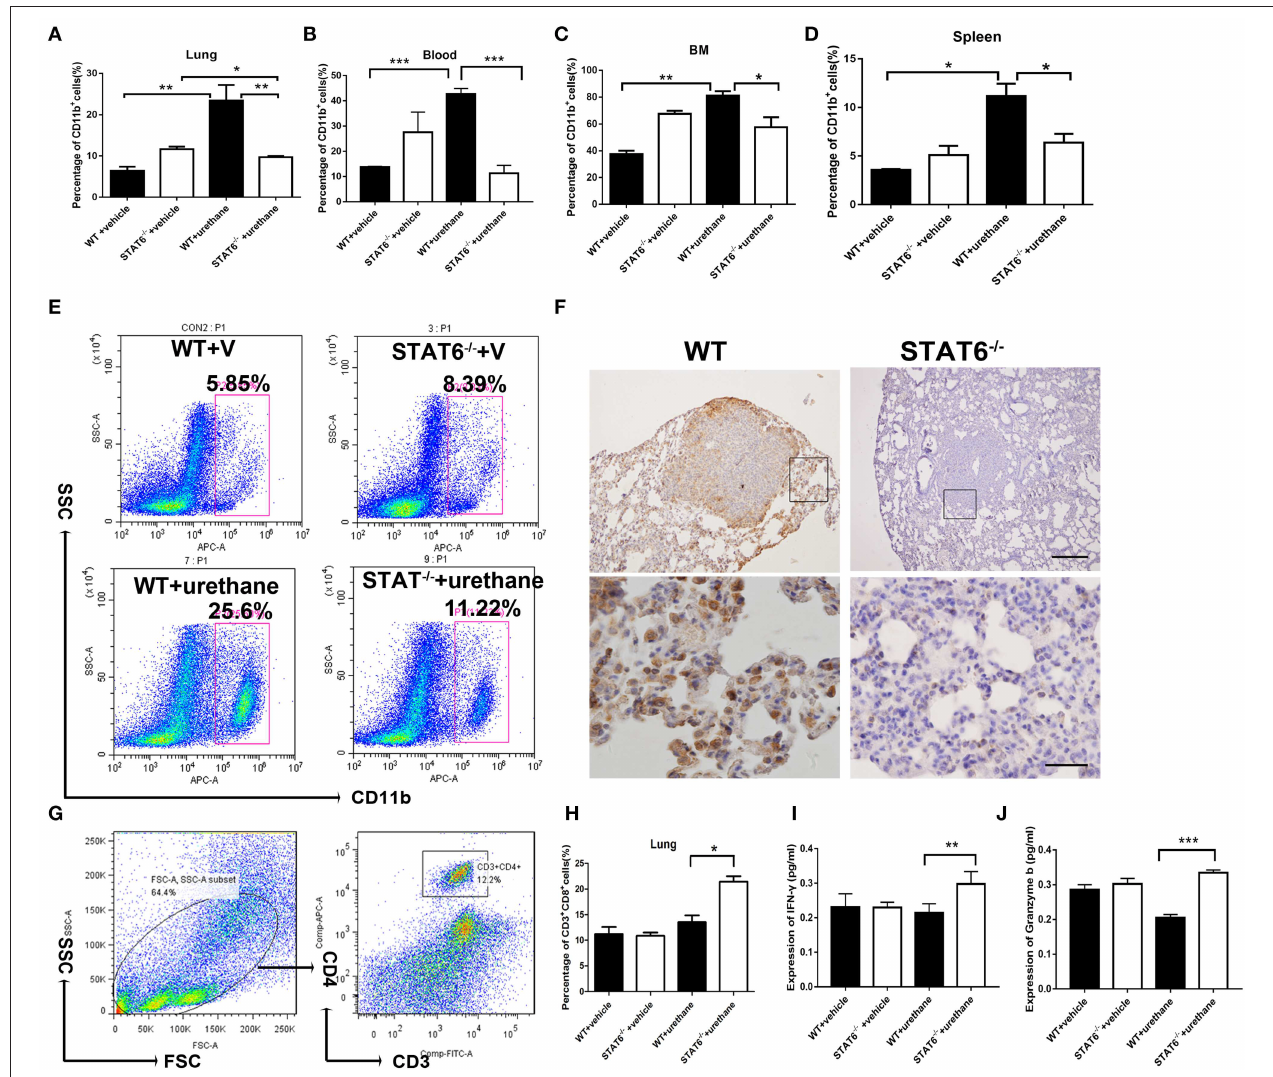
FIGURE 4 | CD11b + cell staining and analysis in tumor-bearing mice. (A–D) Quantification of the percentages of CD11b + cells in the blood, lung, bone marrow, and spleen in WT + vehicle, signal transducer and activator of transcription 6 (STAT6) − / − + vehicle, WT + urethane, and STAT6 − / − + urethane groups. (E) Representative flow cytometry analysis results of CD11b + cells in the lung of STAT6 − / − and WT mice 6 months after vehicle or urethane inoculation. (F) Immunohistochemical (IHC) staining of CD11b + in the lung. The upper and lower bars represent 500 and 200 µ m, respectively. Images in the same row are of the same magnification. (G) Flow cytometry analysis diagram of CD3-CD4 in mice. (H) Percentage of CD3 + CD8 + cells by flow cytometry analysis. (I,J) Expression of cytokines associated with cytotoxic T lymphocytes such as interferon (IFN)- γ and granzyme-b (pg/ml). Data are presented as mean ± SD of one representative experiment. Total number of gated cells was 5 × 10E4. Similar results were obtained in three independent experiments. Unpaired Student’s t -tests were used unless noted otherwise. * P < 0.05, ** P < 0.01, *** P <